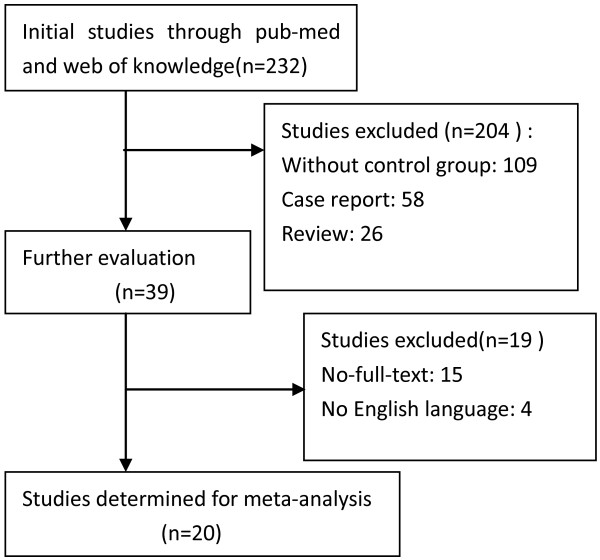
Process for selecting final studies.